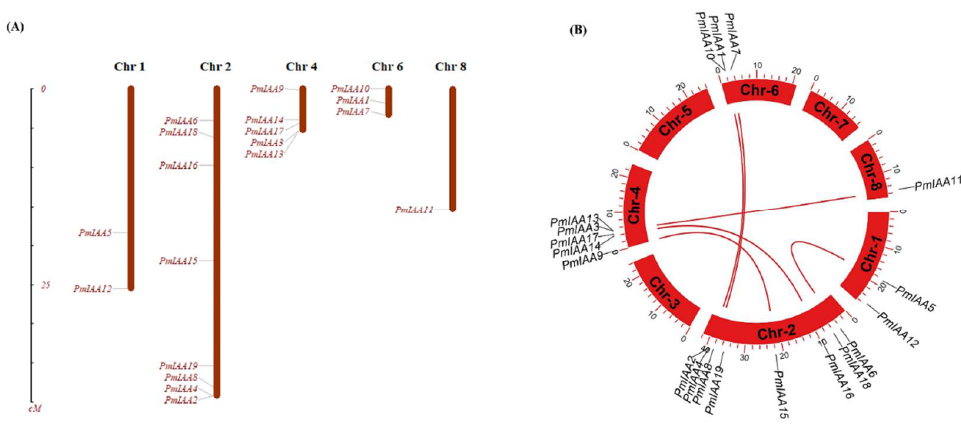
Figure 4. Chromosomal position and gene duplication analysis ( A ) The chromosomal position of each PmIAA gene was mapped according to the Japanese apricot genome ( B ) syntenic analysis for gene duplication showed pairs among different chromosomes The gene IDs on the chromosomes indicate the positions of centromeres and the scale on the circle is in Megabases.